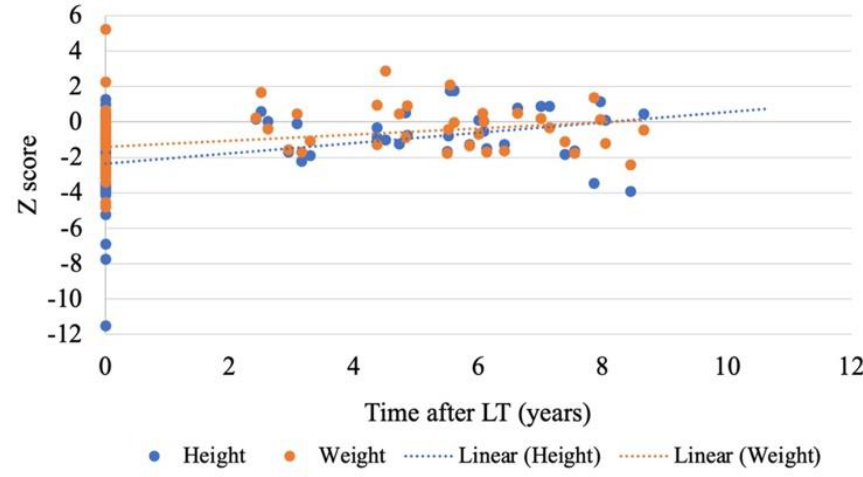
Figure 2. The changes of height and weight Z score after LT. Catch-up growth after LT was witnessed in PFIC patients. The mean height Z score improved from − 2.53 to − 0.55 with a median follow-up time of 5.55 years, and the mean weight Z score increased from − 1.54 to − 0.27. Academic performance was analyzed for school-aged patients. A total of 29/30 (96.7%) of school-aged patients had attended school after LT. Average academic performance was observed in 72.4% of school-aged patients. One patient successfully passed the National College Entrance Exam and started her college study at 18 years old, which was 4 years after LT. One patient dropped out from elementary school due to repeated fatigue symptoms and emotional problems. Retardation in learning ability was also reported, which might be related to the potential encephalopathy-related brain damage before